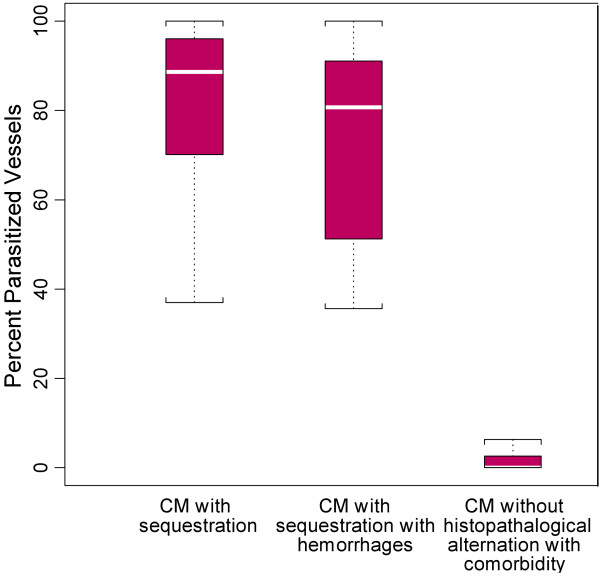
A graphical representation of the first node of the classification tree demonstrating that the resultant cut-offs (23.3% and 21%) were stable but moot as the percentage of vessels parasitized showed no overlap when only patients meeting the clinical case definition of cerebral malaria were analysed.